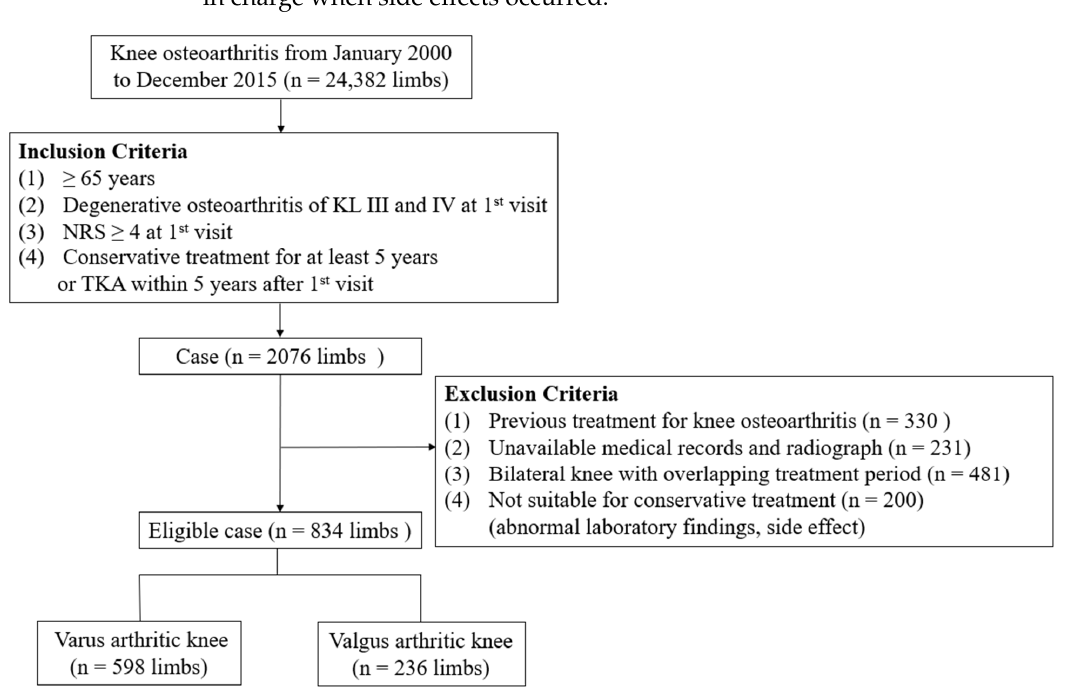
Figure 1. Flow diagram illustrating patient enrollment. n, number; KL, Kellgren–Lawrence; NRS, numeric rating scale; TKA, total knee arthroplasty.